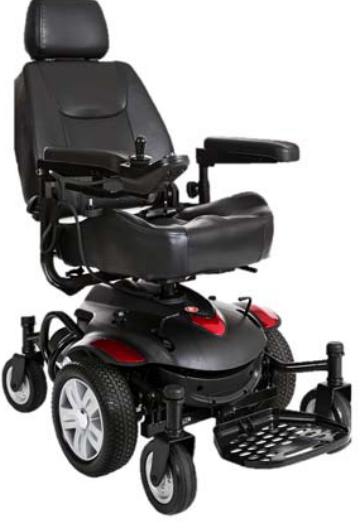
Figure 4. Titan x16 wheelchair.